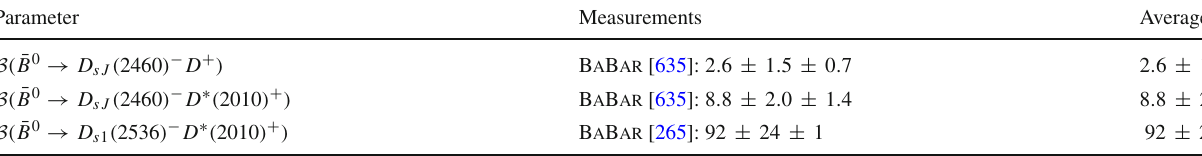
Table 113 Absolute decay rates to excited D s mesons [ 10 − 3 ] Parameter